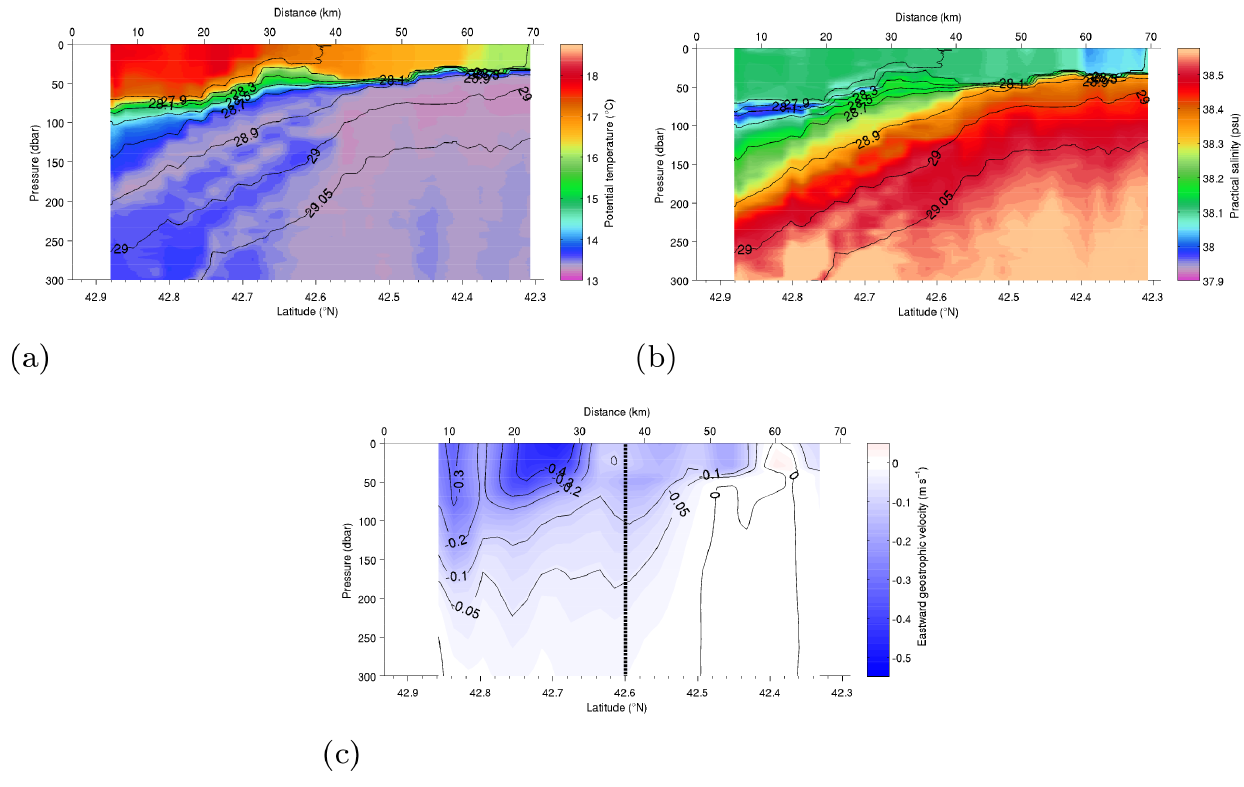
Figure 3. Potential temperature (a) , salinity (b) , and geostrophic velocity (c) for glider Transect 1 (see also Table 1 for time period definition). Potential density anomaly isolines (black) are in panels (a) and (b) . The black dashed line (c) represents the southern boundary of the HF radar